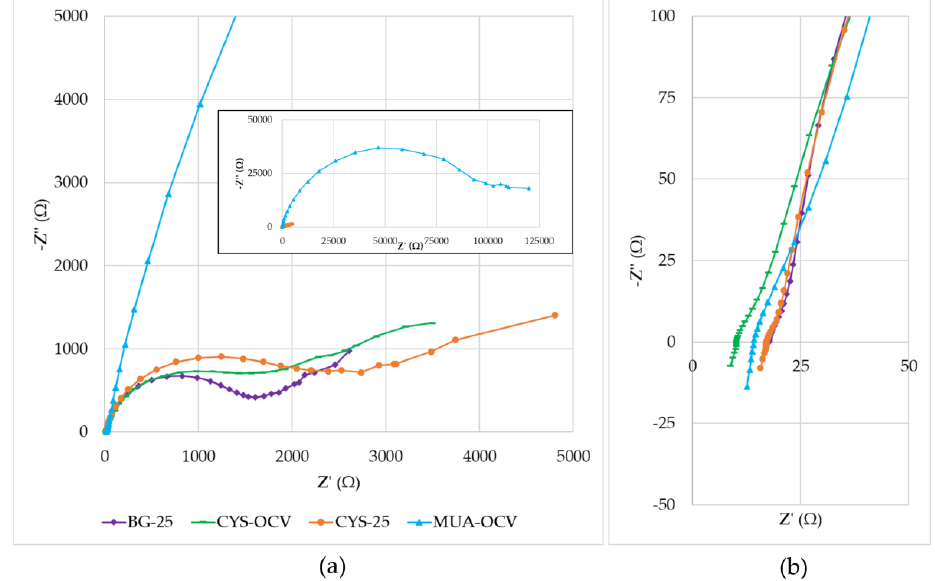
Figure 8. Nyquist plots: ( a ) Inset is the full view, including the low-frequency range for MUA-OCV; ( b ) close-up of the high-frequency region (1 MHz–5 kHz).